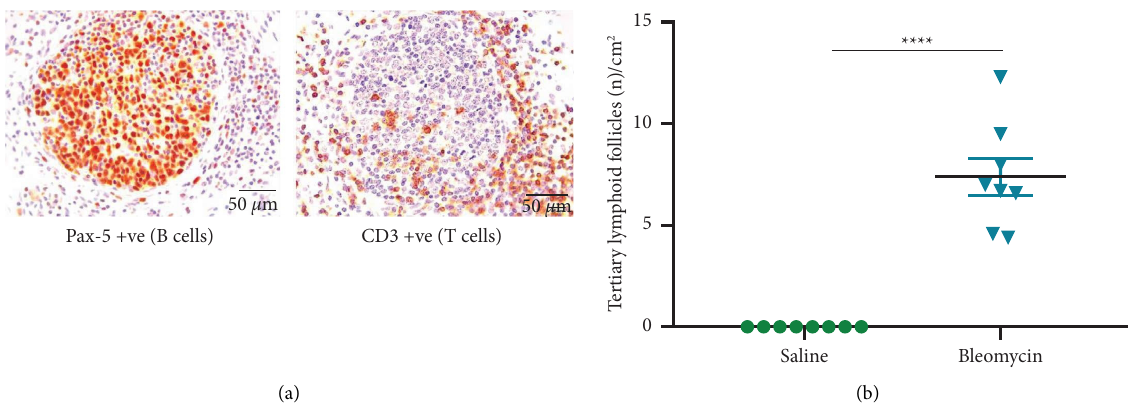
Figure 6: Tertiary lymphoid aggregates in the parenchyma of sheep lung segments exposed to bleomycin. Te top two panels show serial sections immuno-stained with either a Pax-5 primary antibody to identify B-cells or a CD-3 antibody to identify T-cells (a) (40x). Te graph shows the number of tertiary lymphoid aggregates in the lung parenchyma of saline and bleomycin-infused lung segments of sheep ( n � 8) (b). Note that zero lymphoid aggregates were found in saline control lung segments ( n � 8). Each bar represents the mean ± standard error of the mean. Signifcance was determined using the t -test and denoted as follows: ∗∗∗∗ p < 0 .